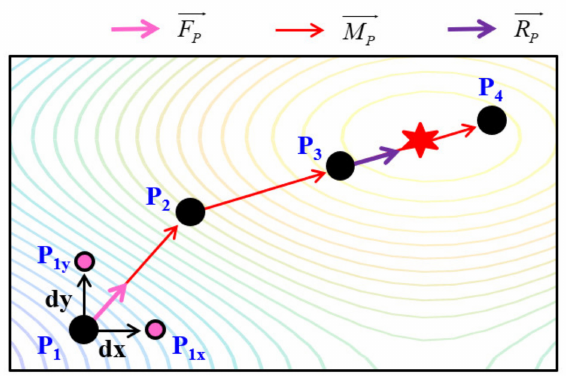
Figure 2. Principle of the